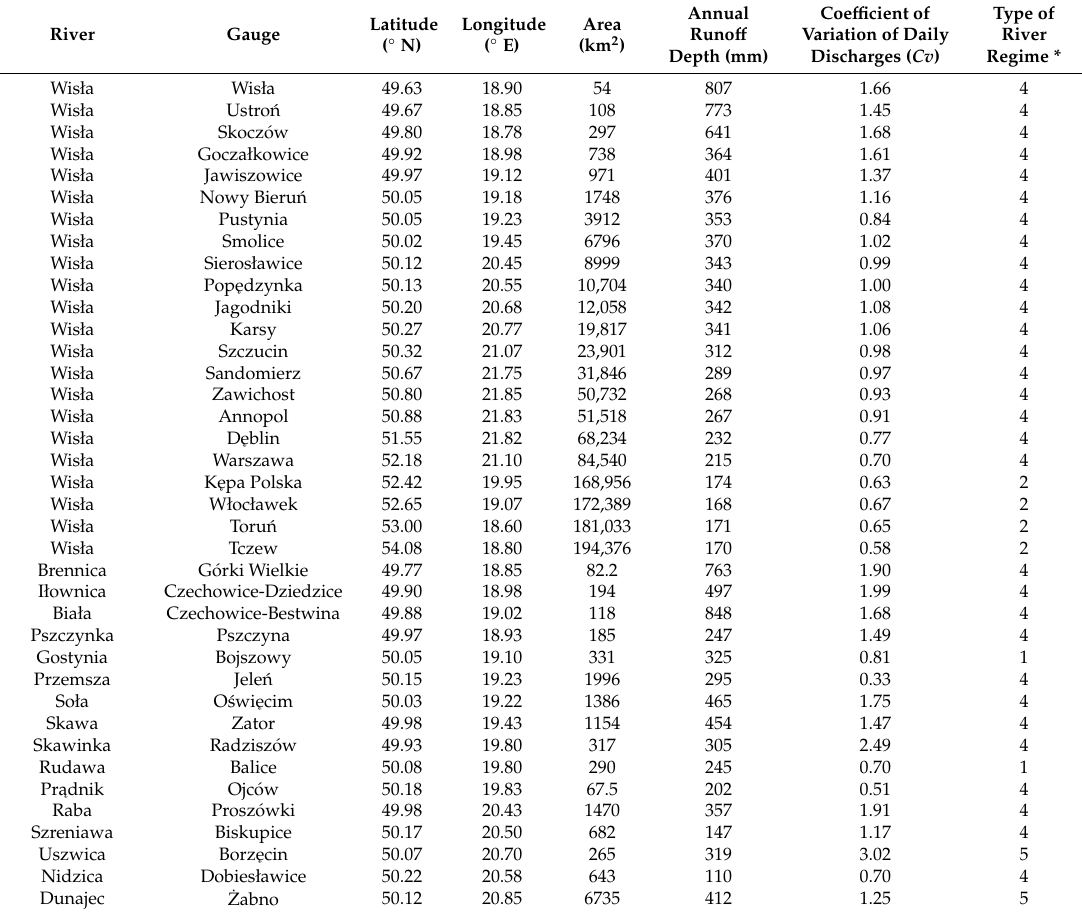
Table 1. Main characteristics of the analyzed rivers in the years